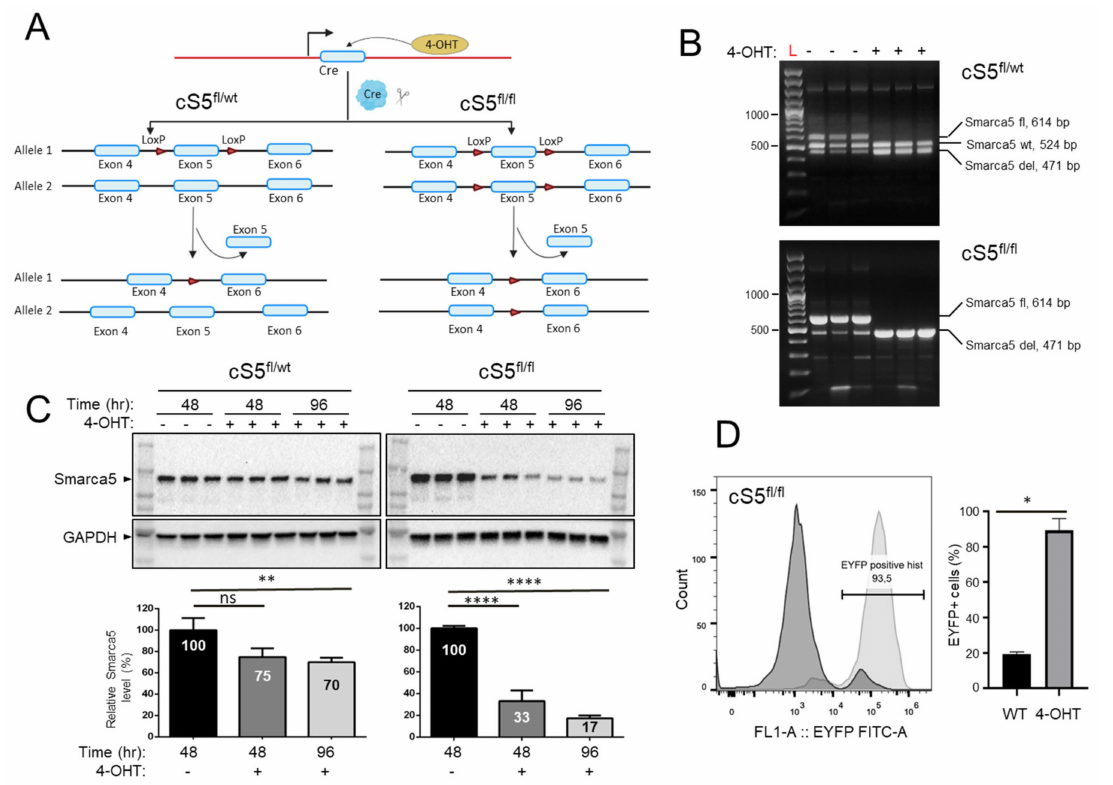
Figure 1. Characterization of the Smarca5 deletion system. ( A ) Schematics of the Smarca5 conditional knockout cassette. The cS5 fl/fl cells have the exon 5 of both Smarca5 alleles floxed, while cS5 fl/wt MEFs have a single floxed Smarca5 allele. The floxed allele(s) is excised upon 4-hydroxytamoxifen (4-OHT) addition. Some elements of the figure were created using BioRender.com. ( B ) Genotyping of the MEFs to confirm Smarca5 deletion status using PCR. The wildtype Smarca5 allele, the floxed allele and the allele with the exon 5 deletion differ in size and can thus be differentiated from each other, revealing the cell identity. DNA was isolated from cells 48 h after adding 4-OHT. Genotyping was done in biological triplicates, each line represents MEF cell line isolated from different embryos with CreER cS5 fl/fl or CreER cS5 fl/wt genotype. The low-representation bands below 300 bp are non- specific background amplicons. ( C ) Immunoblots (in the same triplicates used for genotyping) for anti-Smarca5 antibody reveal protein level depletion over time (48 h and 96 h) in the 4-OHT induced, Smarca5 knockout MEFs compared to control without 4-OHT. A gradual protein level depletion is observed over time. ( D ) Confirmation of Cre-activation upon 4-OHT administration as assessed by expression of the EYFP, 96h after induction. Experiments were done in triplicates, MEF isolated from 3 embryos with CreER +/ − cS5 fl/fl EYFP +/+ genotype. Percent of cells expressing EYFP indicate percent of cells that are also positive for Smarca5 knockout. Dark curve represents cells without 4-OHT and light curve represents same MEFs 96 h after 4-OHT induction, WT/4-OHT = untreated/treated with 4-OHT. ns = p > 0.05; * = p ≤ 0.05; ** = p ≤ 0.01; **** = p ≤